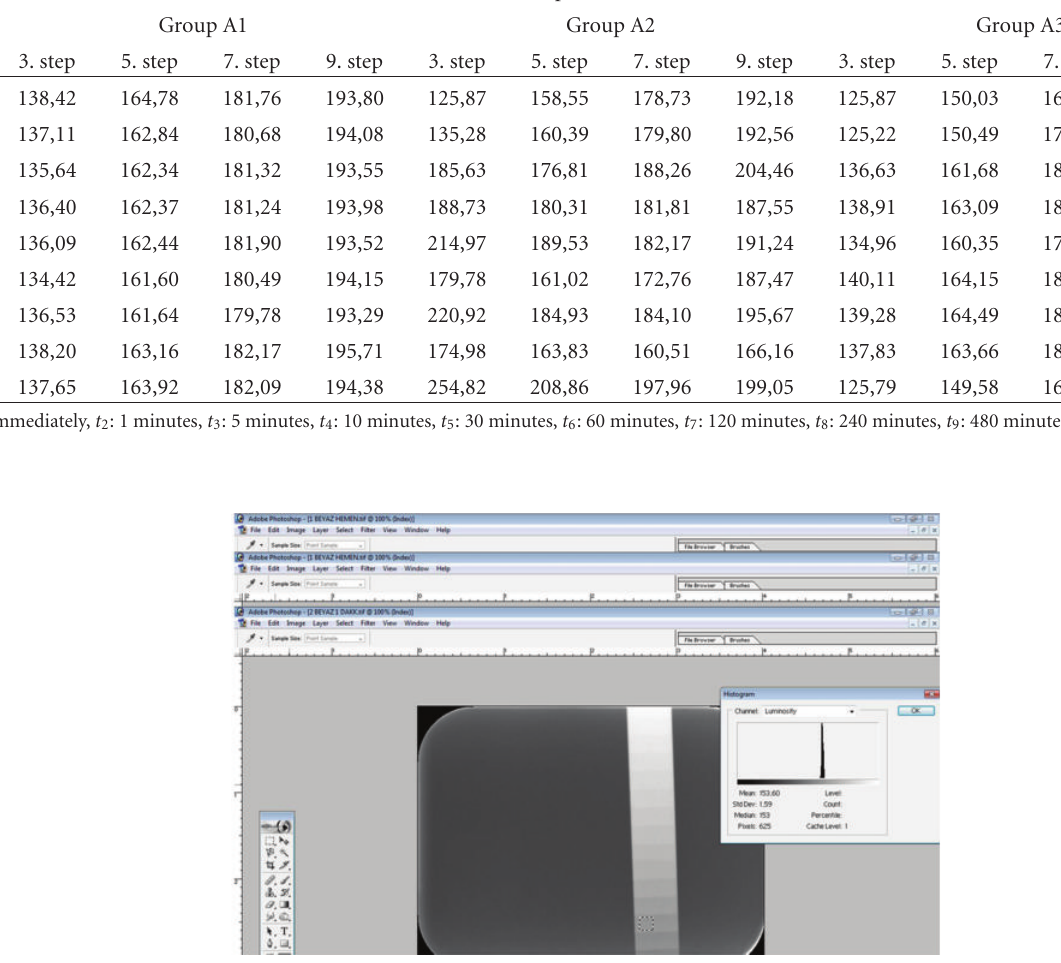
Figure 2: The gray level information of the 3rd step of the Al wedge was sampled with three nonoverlapping (25 × 25 pixel) ROIs using the Photoshop histogram tool.